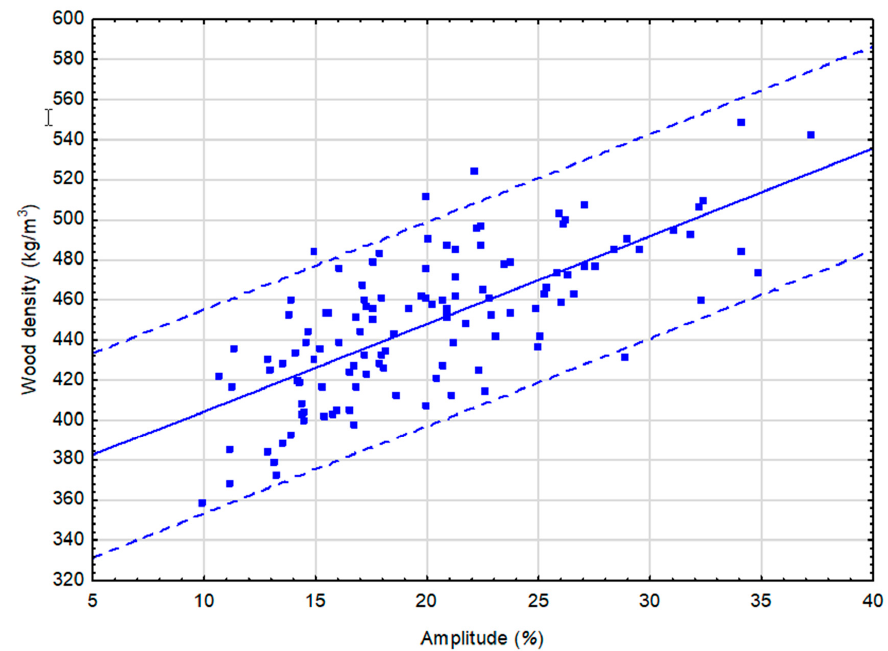
Figure 4. Relationship between mean amplitude and wood density with the significant ( p ≤ 0.05) regression relationship superimposed (solid line, Equation (6), Table 6). Denoted by the superimposed dashed parallel lines are the 95% prediction limits for absolute error (Equation (10), Table